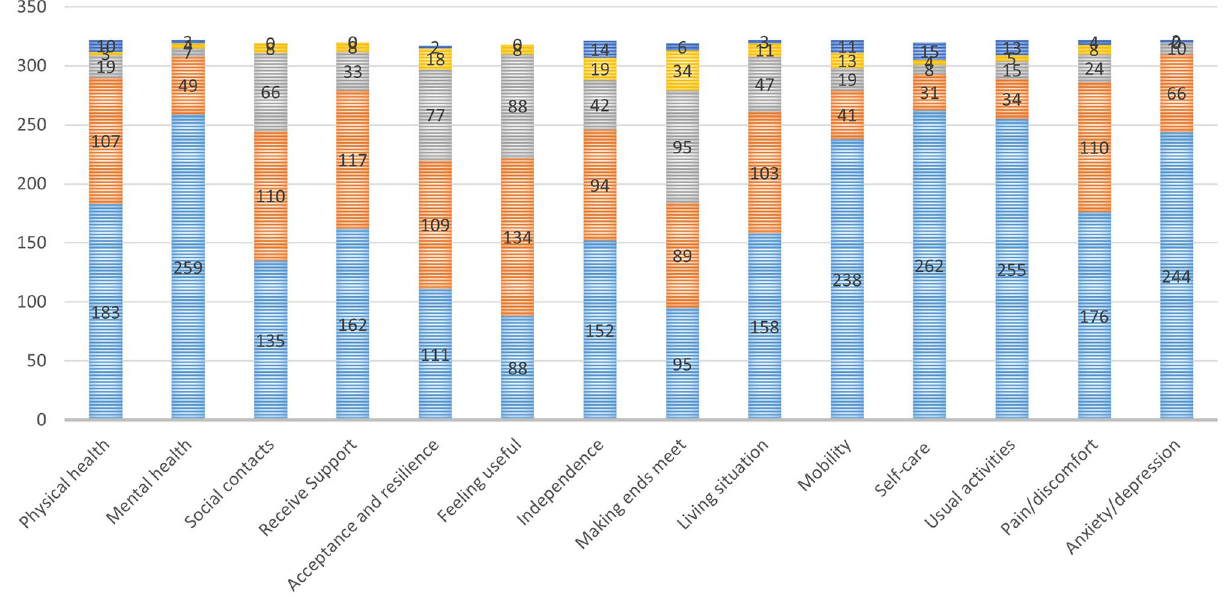
Figure 1. Response distributions of EQ-5D-5L and